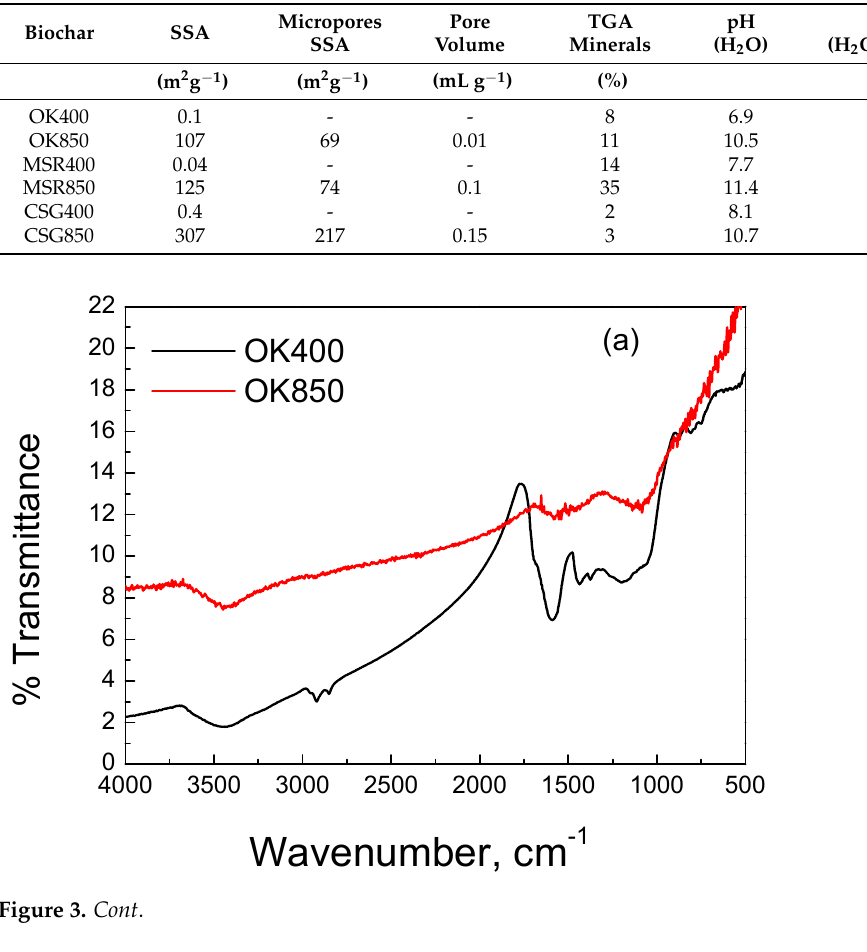
Table 2. Physicochemical characteristics of the biochars studied.